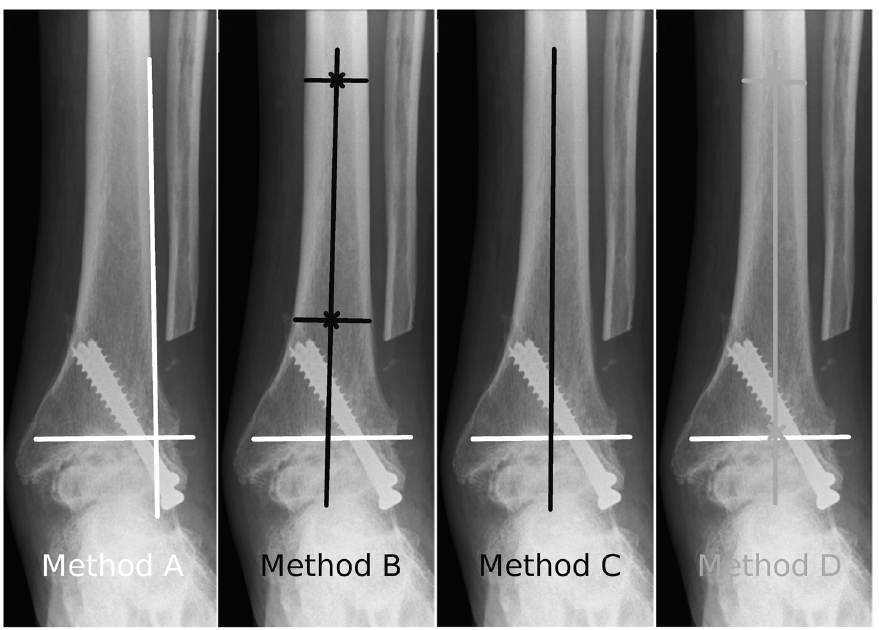
Fig 3. Measurement methods for the FTTA. Diagrams depicting the four different methods for drawing the longitudinal axis of the tibia for FTTA measurement on anterior to posterior radiographs.